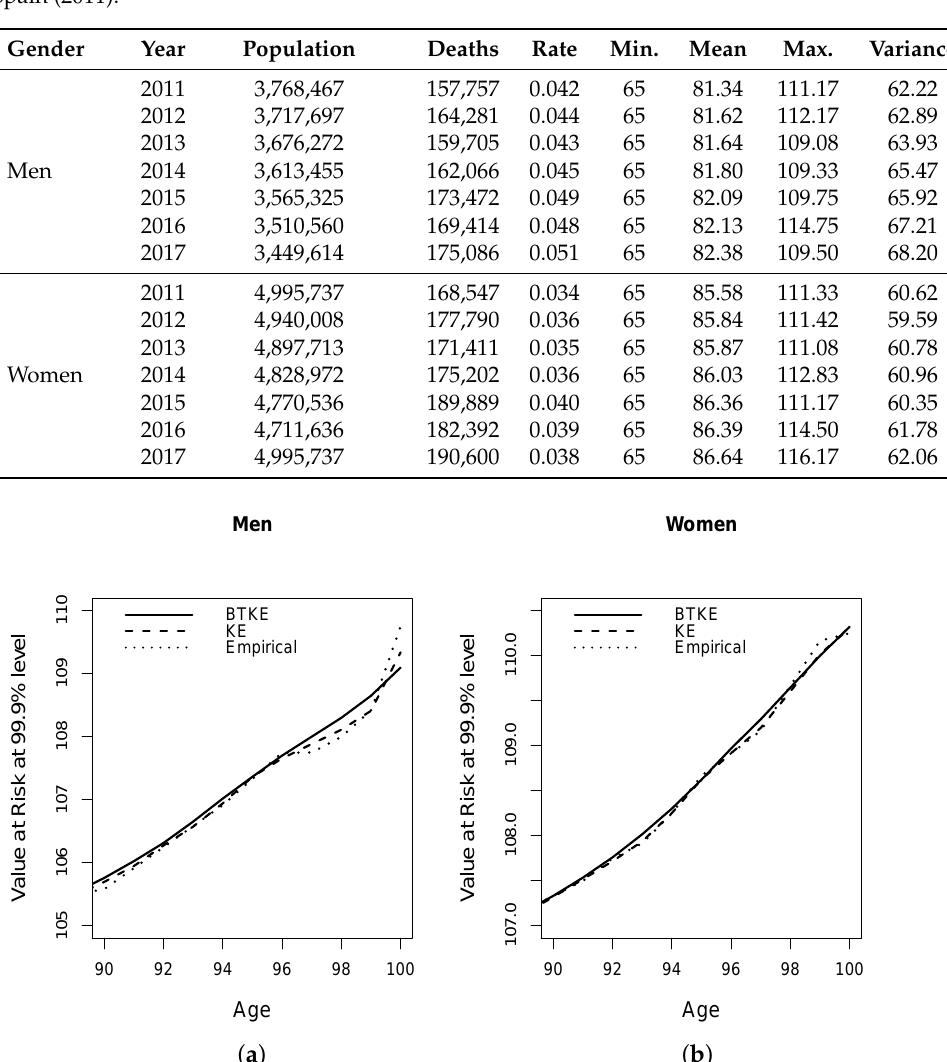
Figure 1. CQ p for the year 2015 of the age-at-death variable for the population in Spain estimated a from the Beta Transformed Kernel Estimator (BTKE), kernel estimator (KE) and empirical distribution, for men ( a ) and women ( b